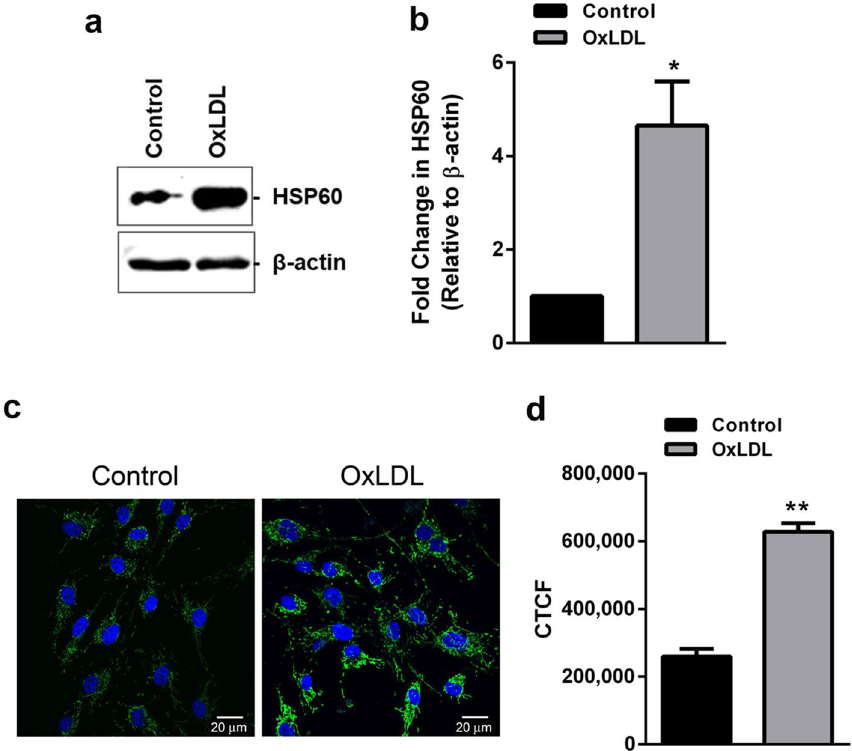
Figure 1. HSP60 expression in OxLDL treated HUVEC. Cells were treated with OxLDL (80 µg/ml) for 24 h and expression of HSP60 was evaluated by ( a ) western blotting followed by ( b ) its densitometric analysis and ( c ) immunocytochemistry followed by ( d ) its quantification by Image J analysis. Scale bar = 20 µm. CTCF corrected total cell fluorescence. Data were expressed as Mean ± SEM (n = 3). *p < 0.05, **p < 0.01 vs untreated control, unpaired two-tailed Student’s